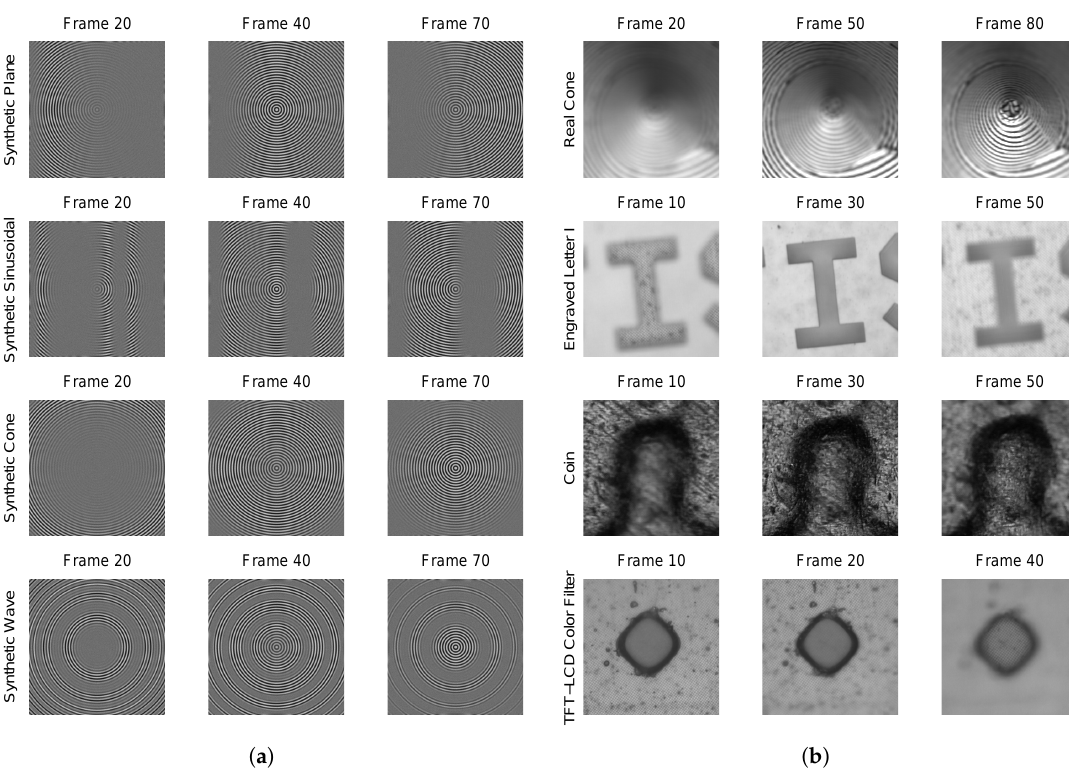
Figure 6. ( a ) Sample frames from image sequences of synthetic objects: plane object (first row), sinusoidal object (second row), cone object (third row), and wave object (fourth row). In addition, each column shows frame number 20, frame number 40, and frame number 70. In a sample frame, the texture clearly distinguishes only at the well focused area; ( b ) Sample frames from image sequences of real objects: real cone (first row), engraved letter I (second row), coin (third row), and TFT-LCD color filter (fourth row). In a sample frame, the texture clearly distinguishes only at the well focused